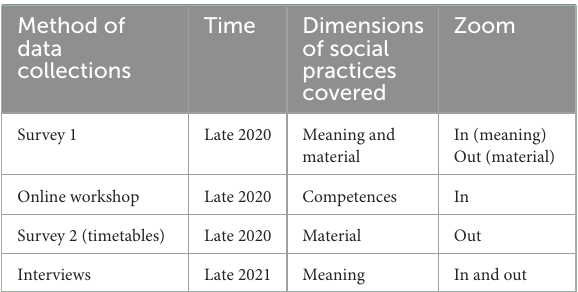
TABLE 2 Overview of data collection methods used and what they